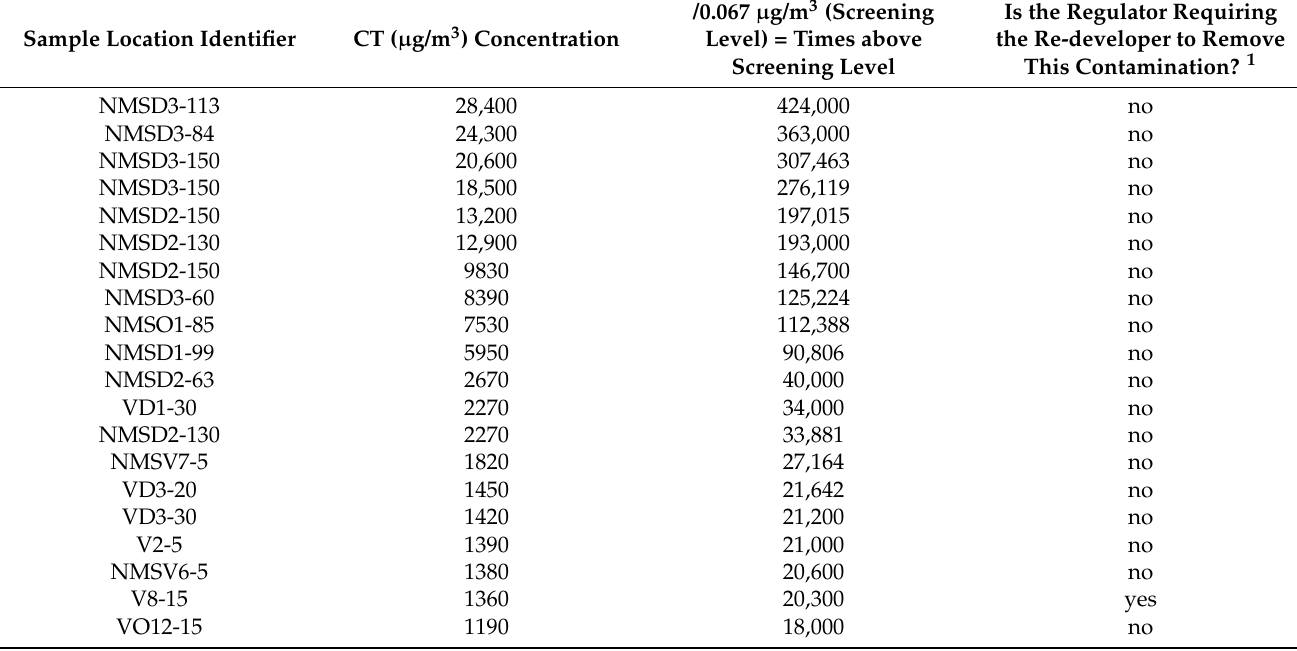
Table 2. Soil-Gas Carbon Tetrachloride (CT): Up to 5 Orders of Magnitude above the Health-Protective, Environmental Screening Levels (ESLs)